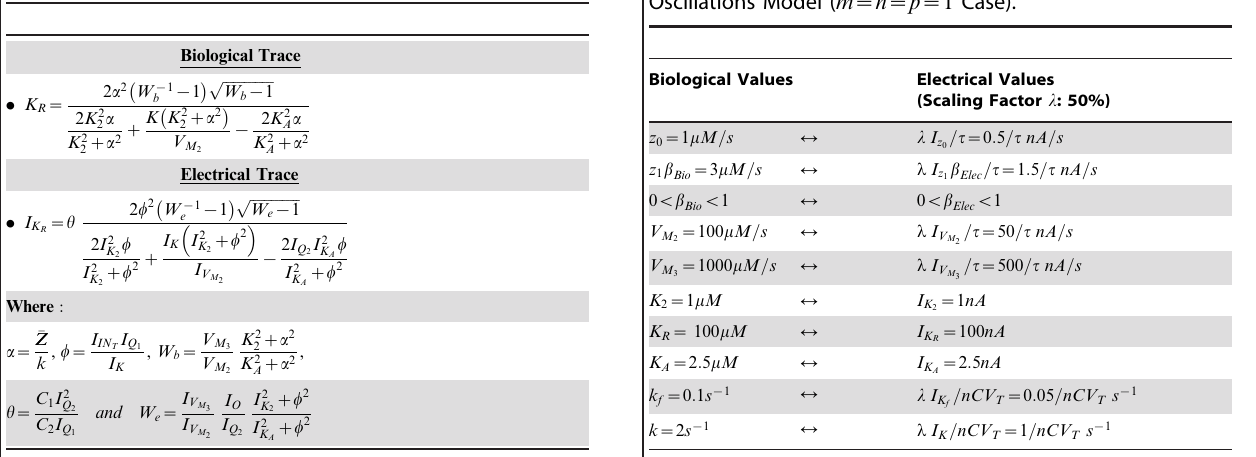
Table 3. Regions Of Oscillations For Intracellular Ca 2 z Biological Model And Its Electrical Equivalent. Table 4. Biological And Electrical Values For The Ca 2